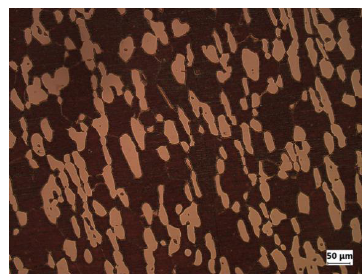
Figure 1. Optical micrograph of S32750 stainless steel (the dark region is ferrite and the bright region is